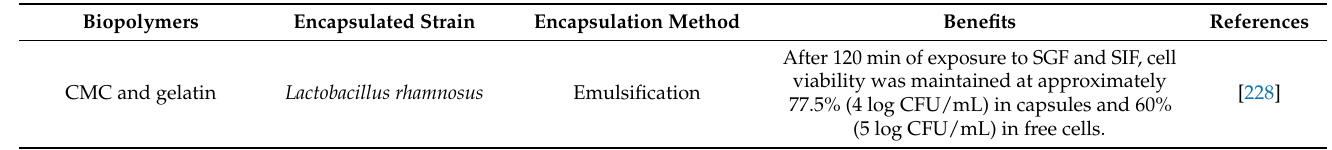
Table 8. Cellulose as a probiotic encapsulating